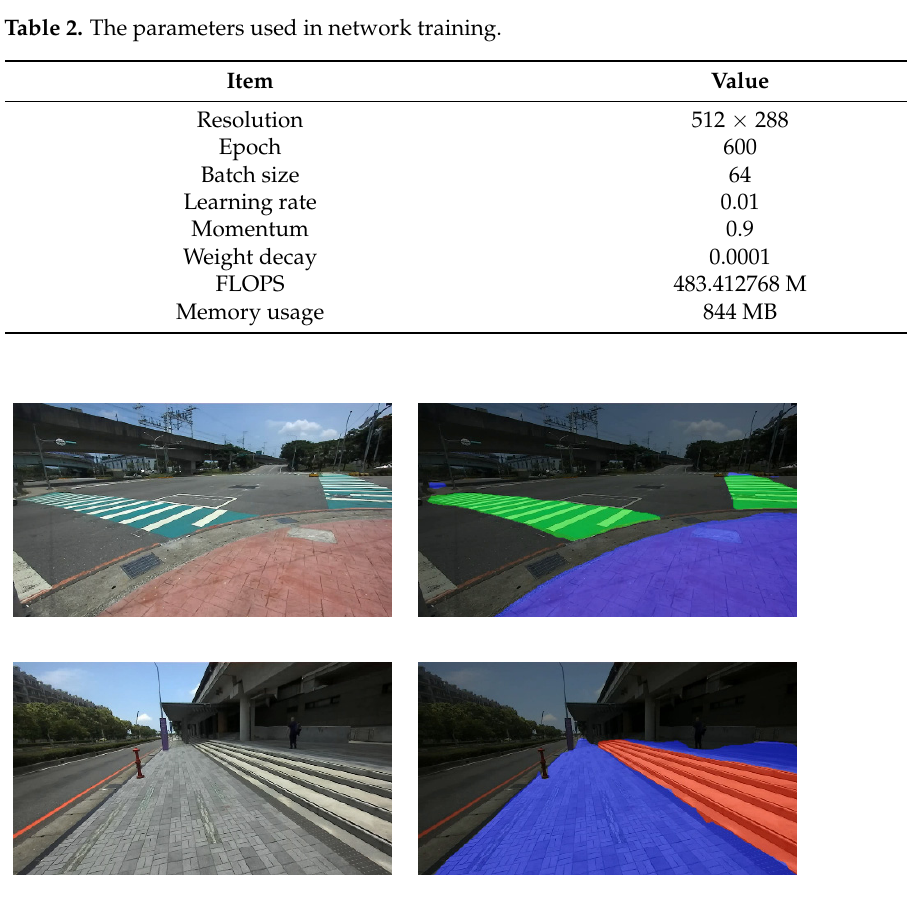
Figure 3. Street view image from ZED 2 and the result of Fast–SCNN. Table 3. The performance of FAST-SCNN.